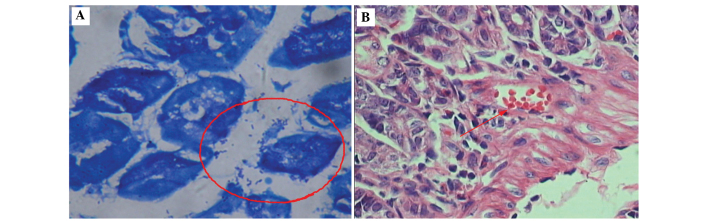
(A) Giemsa staining of the gastric mucosa (magnification, x400). Mice were euthanized 12 weeks after the H. pylori inoculation and the tissue sections were stained by Giemsa staining. The red circle indicates H. pylori colonization in the gastric pits. (B) Hematoxylin and eosin staining of the gastric mucosa (magnification, x400). Mice were euthanized 12 weeks after the H. pylori inoculation. The red arrow indicates mucosal hyperemia, lymphocytes and neutrophil infiltration.